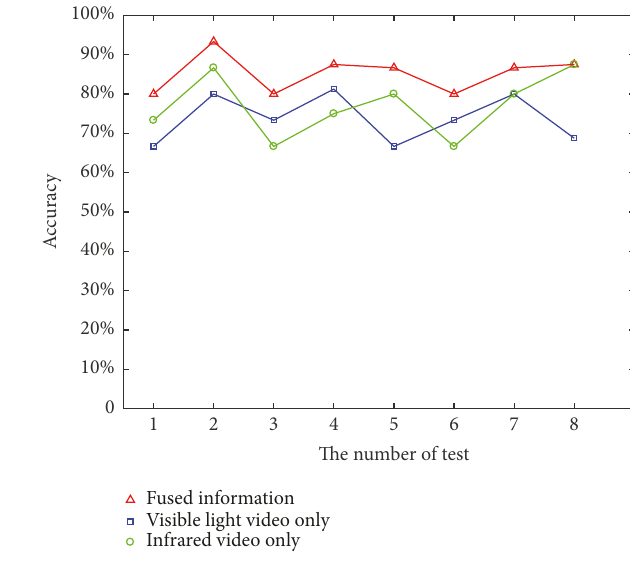
Figure 11: The results of 8-fold cross validation. Table 5: The efficiency of background